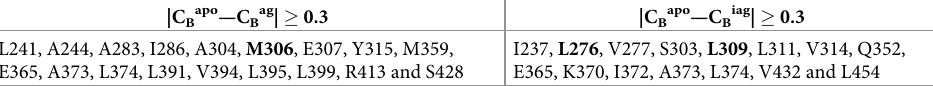
Table 5. Critical residues with betweenness centrality values |CBapo—CBag/iag| � 0.3. Bold residues represent residues common in both ERR γ ag and ERR γ iag .